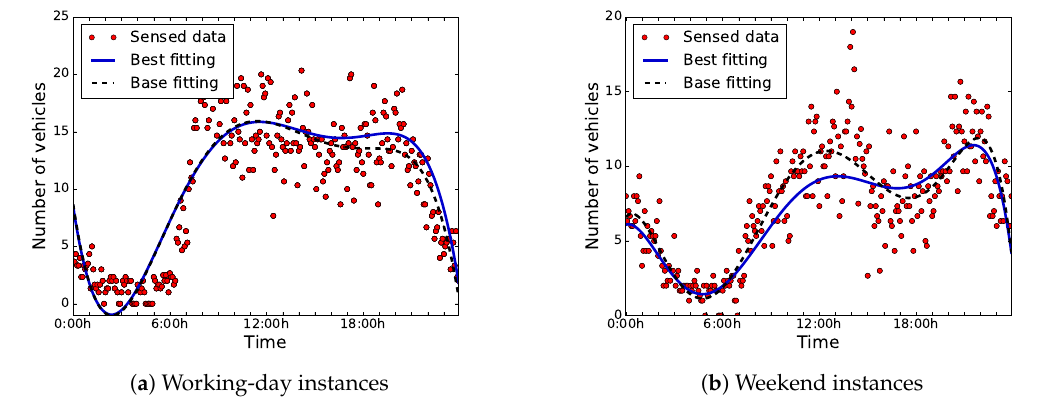
Figure 13. Best-found fitting